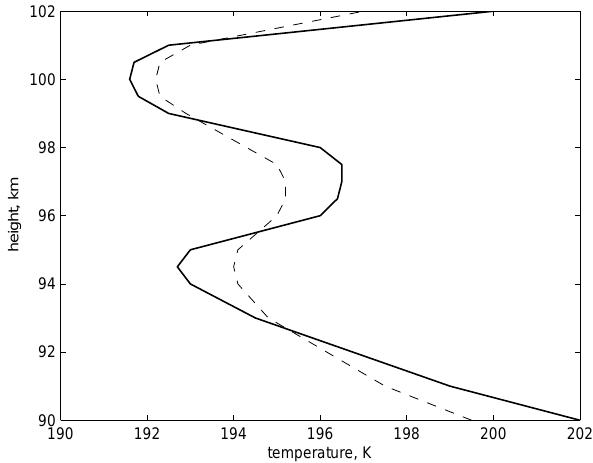
Fig. 10. Temperature height profiles measured by the TOMEX lidar (solid line) (Hecht et al., 2004) and calculated by the model (dashed line).